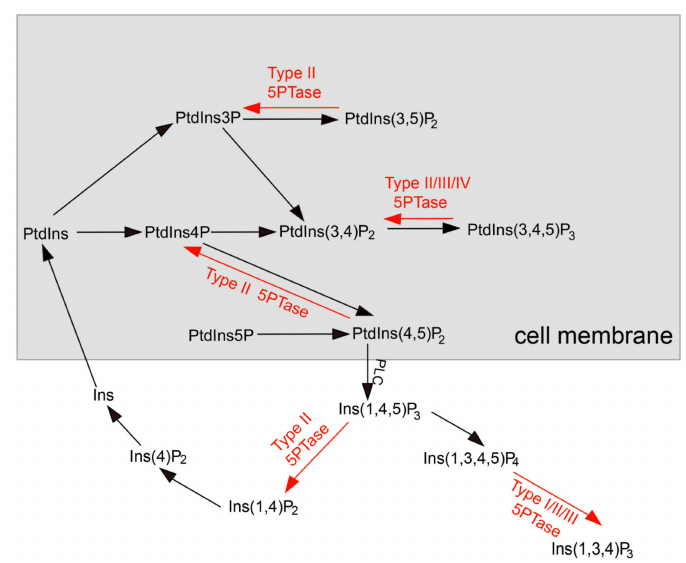
Figure 1. The phosphoinositide metabolic pathway in plants. The free hydroxyl groups of the phosphatidylinositols (PtdIns) can be phosphorylated at positions 3, 4, and / or 5 by distinct kinases (black arrows) to generate various phosphoinositides. Phospholipase C (PLC) can convert substrate PtdIns(4,5)P 2 into the second messenger Ins(1,4,5)P 3 . The action of inositol polyphosphate 5-phosphatases (red arrows) modulates the signaling functions of these